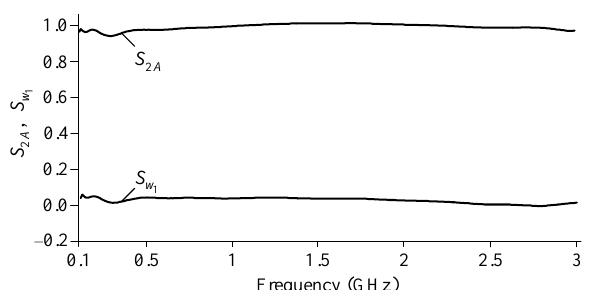
Fig. 6. Impact coefficients on the phase delay time of a system when changing: (a) the gap s between adjacent meander conductors; (b) the width w 2 of additional shield.